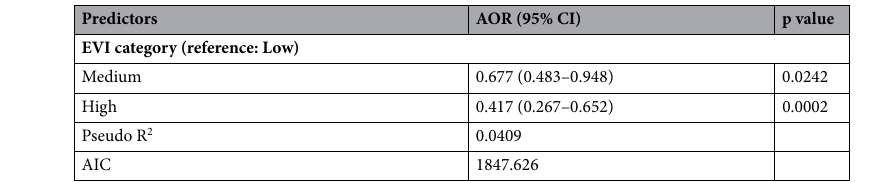
Table 4. Association between residential area greenness (EVI category) and diabetes among adults in Bangladesh. AOR adjusted odds ratio, CI confidence interval, AIC Akaike information criteria; model is adjusted for individual-level age, sex, education status, working status, and marital